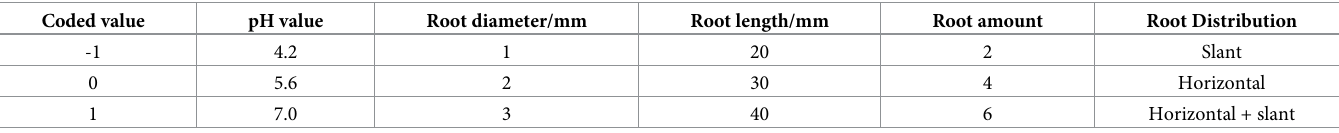
Table 2. Response surface analysis factor level